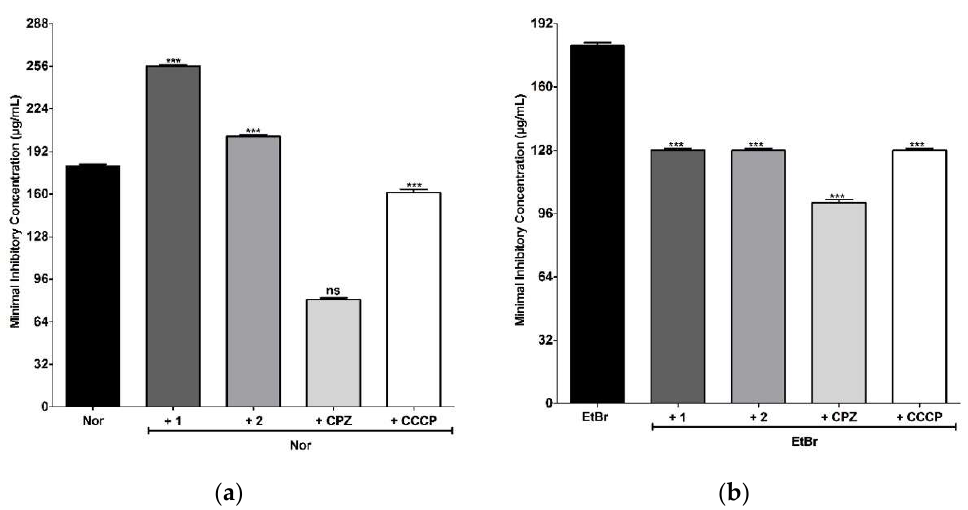
Figure 10. MICs of the Norfloxacin (Nor) (a) and Ethidium Bromide (EtBr) (b) in the absence or presence of the chalcones 1 and 2, as well as, Chlorpromazine (CPZ) and Carbonylcyanide m-chlorophenyl hydrazone (CCCP) at sub-inhibitory concentrations (MIC 1/8) against SA1199-B ( norA ). Each result is the geometric mean of three simultaneous experiments. (***) Statistically significant values ( p < 0.0001).